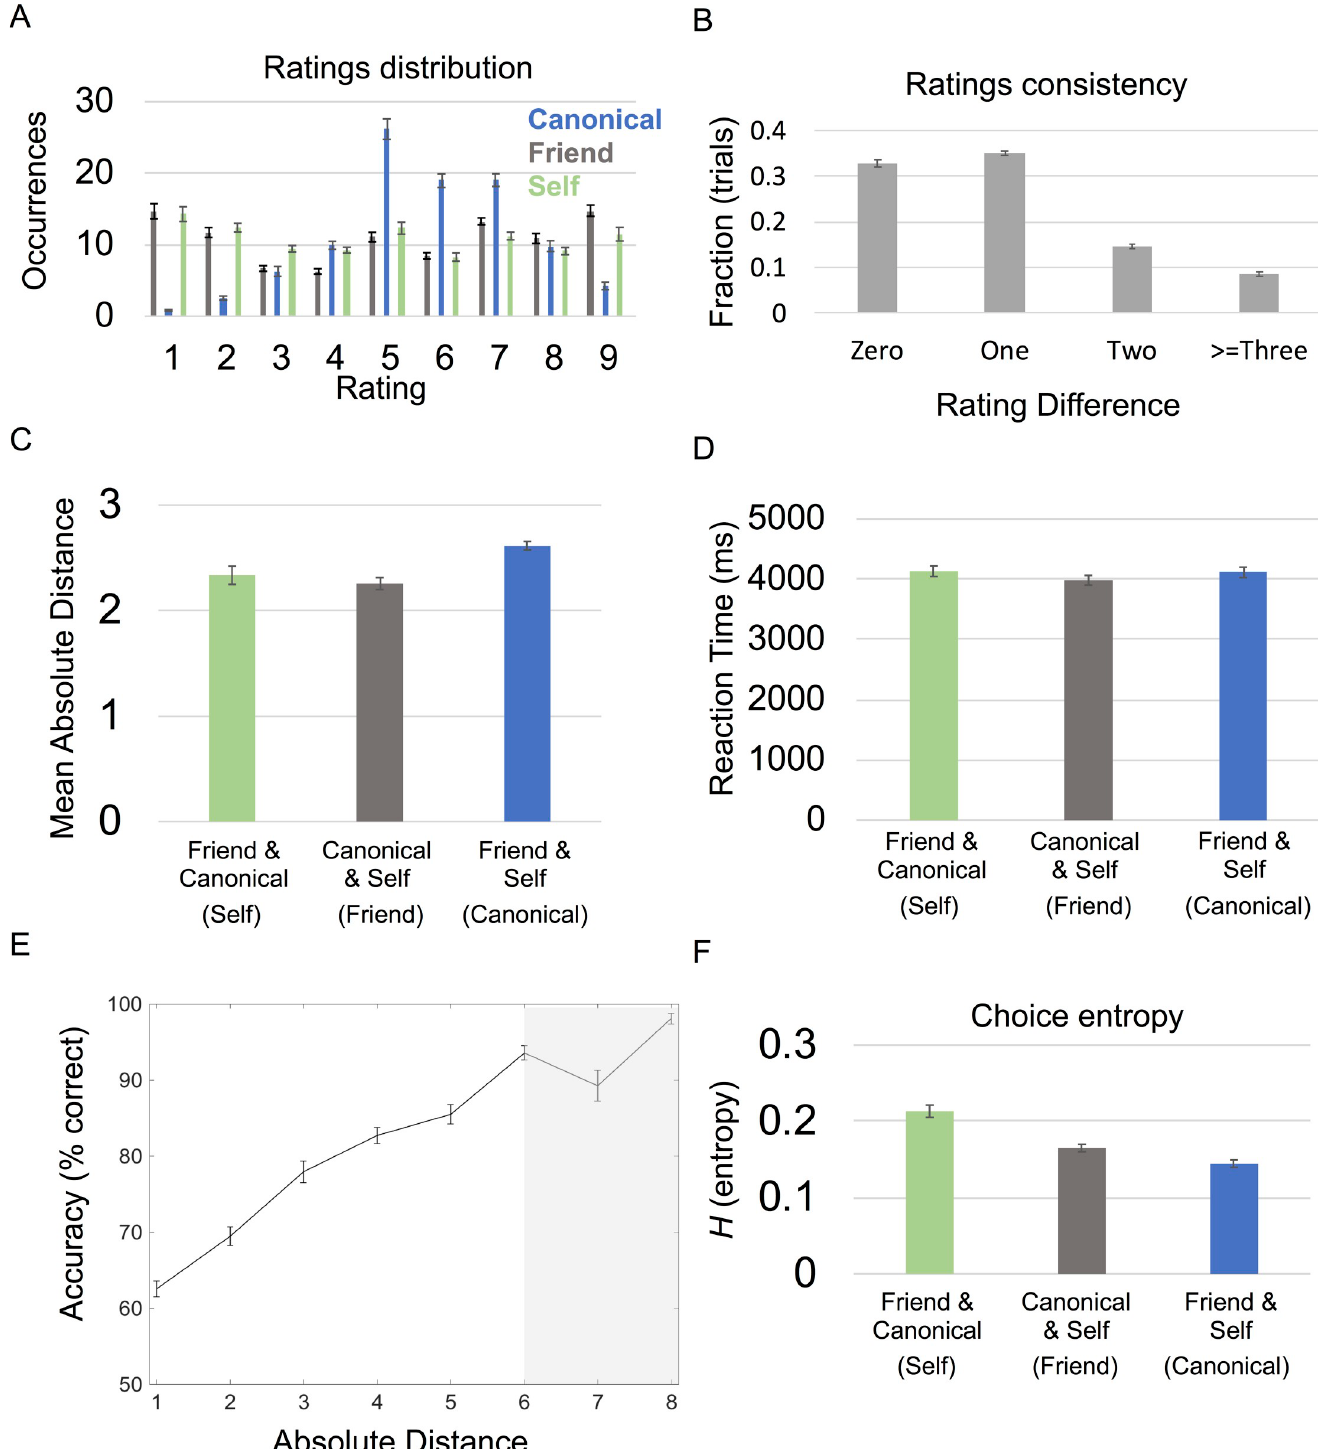
Fig 2. Behavioral results. A. Mean ratings across subjects for each familiar individual and every scenario. Occurrences are out of the 100 total trials per condition. B. Rating consistency. Difference in ratings pre- and post-fMRI scanning for friend and canonical individuals C. Distribution of mean absolute distances by condition. Significant effect of condition for absolute distance between the two individuals’ ratings and the stranger’s ( P = 0.001). Individuals being compared are listed in the key with the corresponding anchor/condition name listed in parentheses. D. Reaction time: Significant effect of condition for reaction time/decision speed ( P = 0.022). Individuals being compared are listed below each bar with the corresponding anchor condition listed in parentheses. E. Absolute distances and